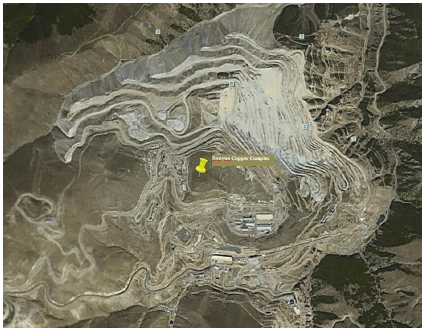
Fig. 4. Location map of Sungun Copper Complex